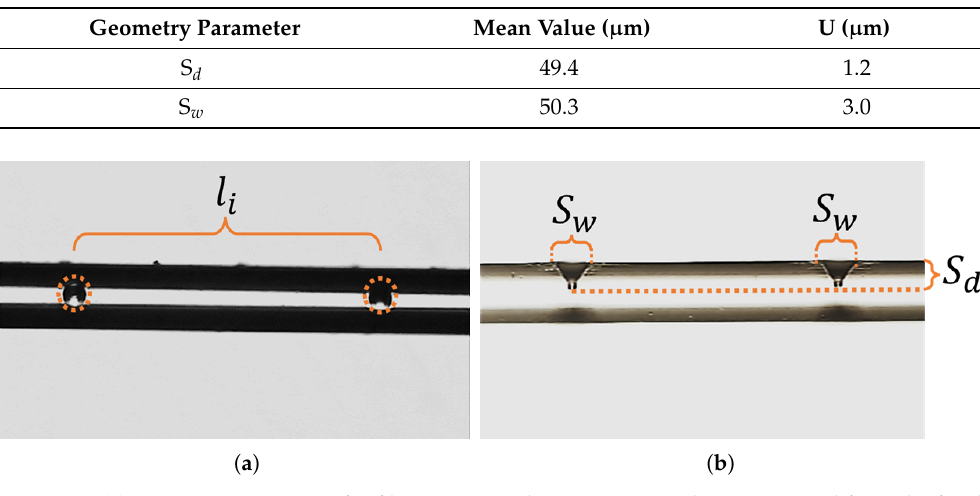
Figure 5. ( a ) Measurement points for fiber gratings; the grating period was extracted from the focal plane observed. ( b ) The engraved spot surface width and penetration depth were